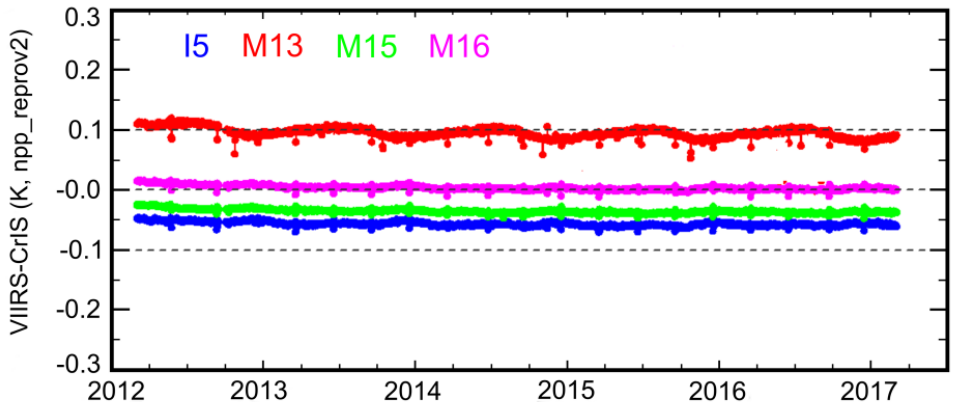
Figure 15. Daily averaged VIIRS–CrIS BT difference time series (March 2012 to February 2017). Reprocessed VIIRS and CrIS normal spectra data at nadir were used.